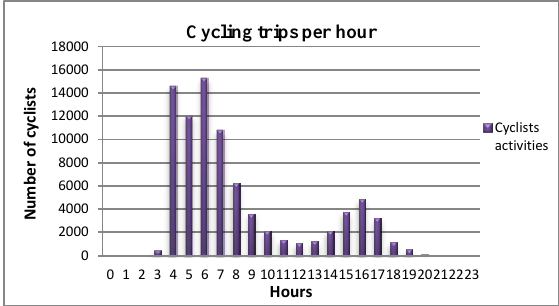
Figure 3: All cycling trips per